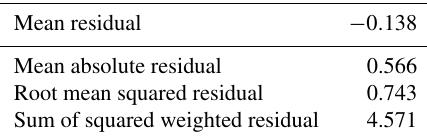
Table 2. Data of model calibration.